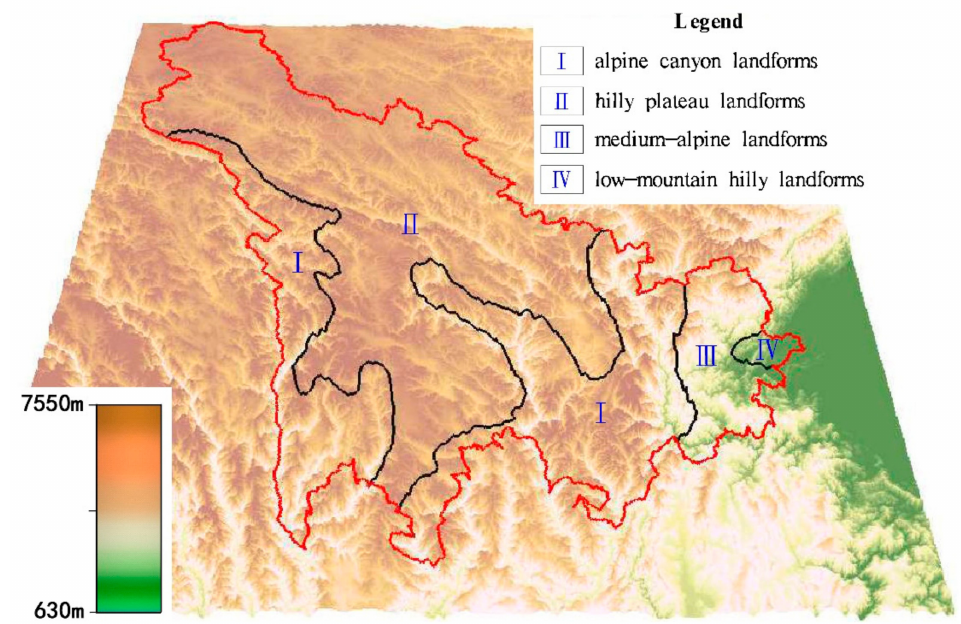
Figure 2. The topography of the study area. For meteorological conditions and vegetation coverage, Garz ê Prefecture has a Qinghai- Tibet Plateau climate with less rainfall and has an average annual rainfall of 500 to 800 mm. The average annual rainfall in the Jinsha River Valley is even lower than 500 mm, and